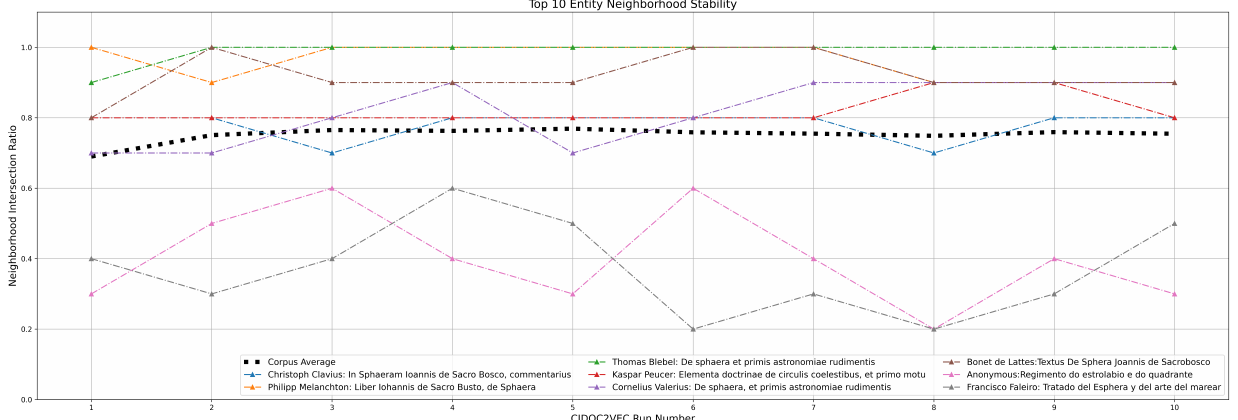
Figure 8. Main entity neighborhood stability over 10 CIDOC2VEC